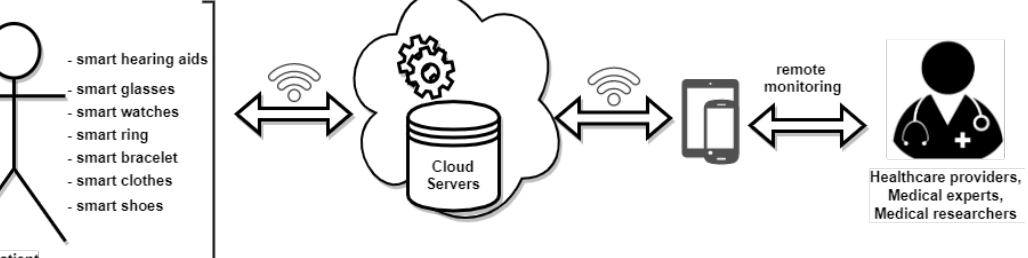
Figure 1. General architecture of an mHealth